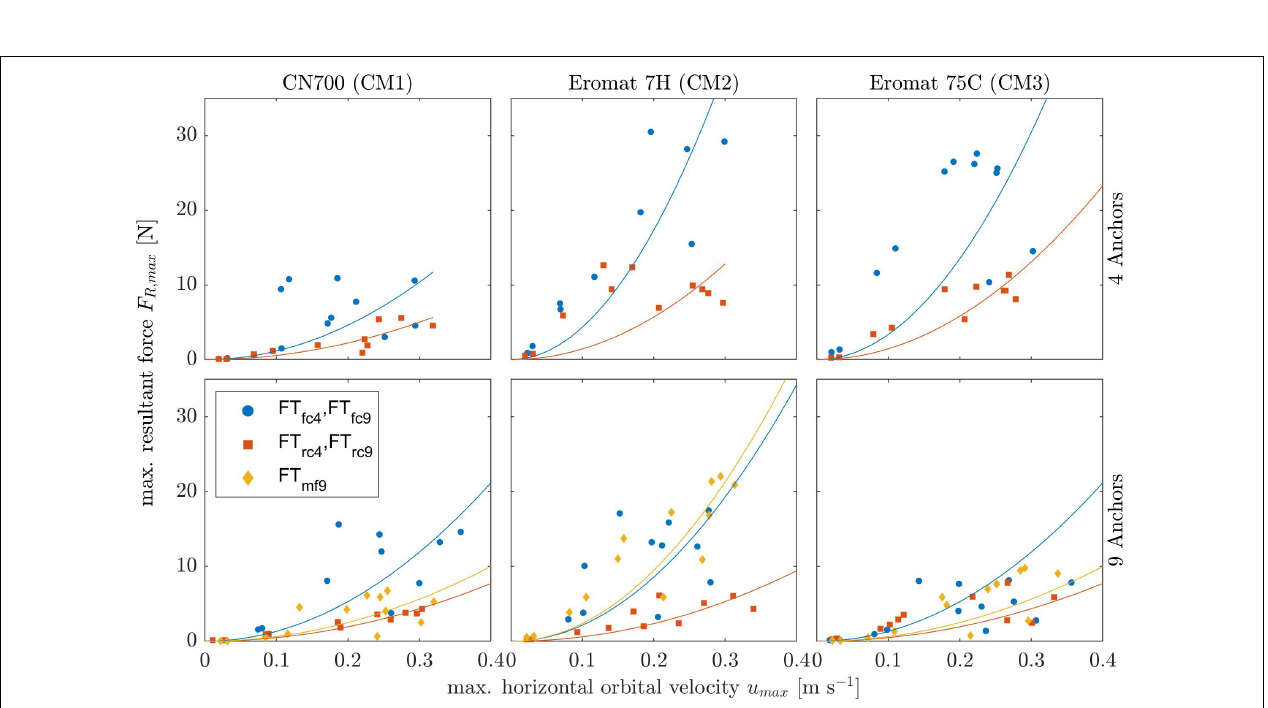
FIGURE 9 | Resultant forces at all anchor positions for the experiments on coir mats (CM). Columns: mat type; rows: number of anchors. The subscripts in the legend indicate the anchor position of the measurement, with f = front, c = corner, m = middle, and 4 and 9 representing the number of anchors. A quadratic fit of form F R = α u 2 max is shown for reference, color-coded for the respective